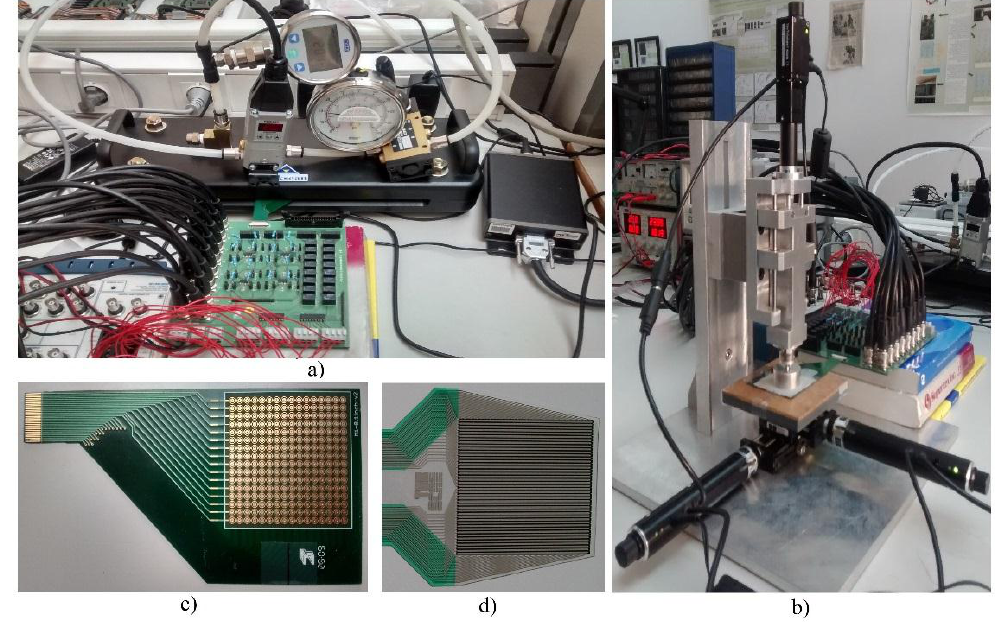
Figure 1. ( a ) Pneumatic commercial setup Tekscan PB100E; ( b ) Motorized stage; ( c ) PCB based tactile sensor; ( d ) Commercial Sensor Tekscan